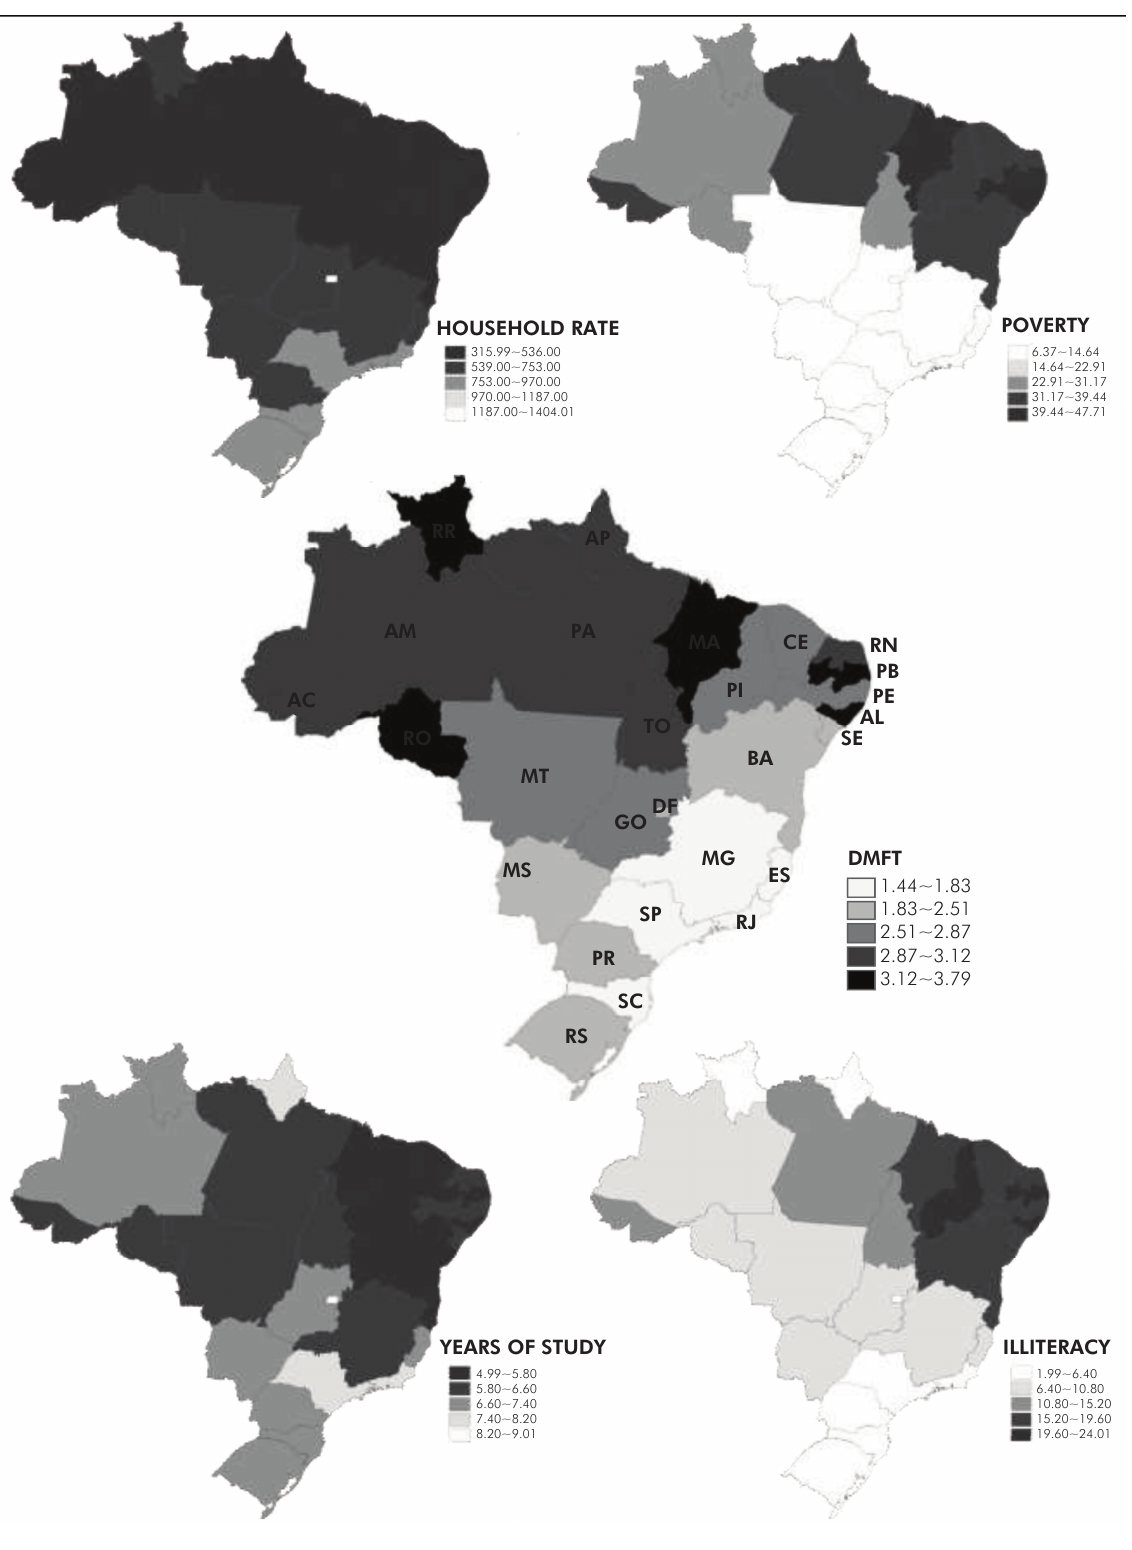
Figure 1. Exploratory spatial distribution map of DMFT in 12-year-olds (Center) among Brazilian states in 2010 and spatial distribution of the variables household per capita income, poverty rate, schooling, and illiteracy